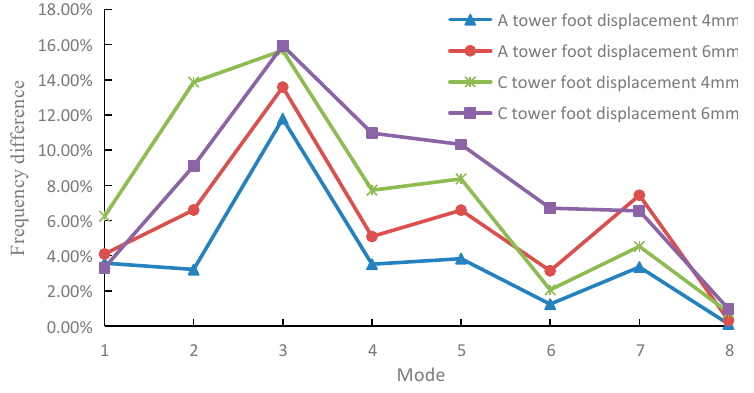
Figure 10. Change of modal frequency in the X direction of the A and C tower feet before and after settlement.